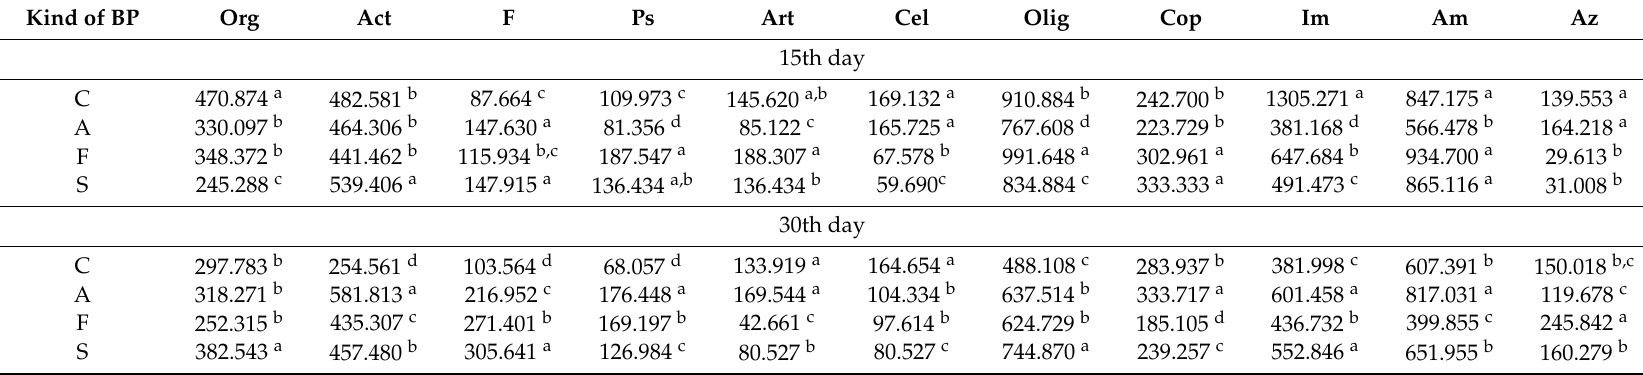
Table 2. The number of microorganisms in soil contaminated with BPA, BPF and BPS on the 15th and 30th day of the research, (cfu 10 n kg − 1 d.m. of soil). Kind of